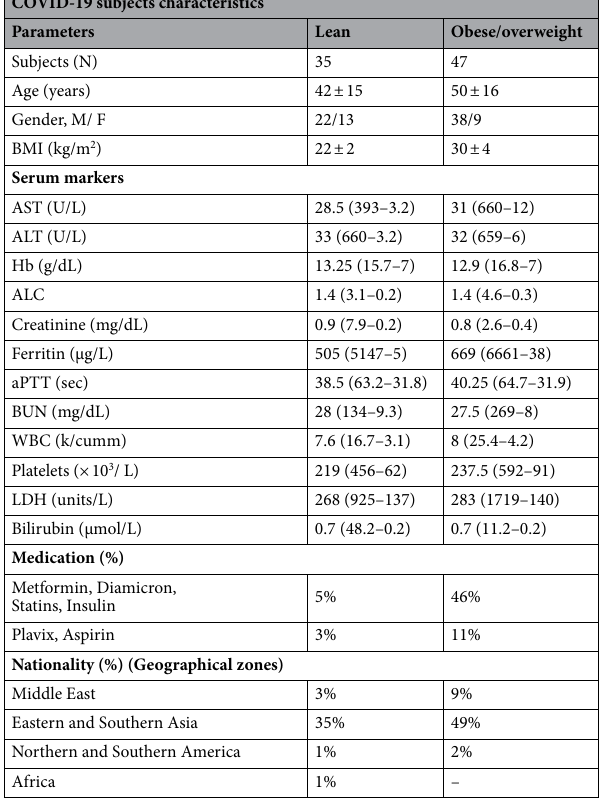
Table 3. COVID-19 patients’ characteristics. BMI body mass index; AST aspartate aminotransferase test, ALT alanine aminotransferase test; Hb haemoglobin; ALC haemoglobin A1c test; aPTT activated partial thromboplastin clotting time; BUN blood urea nitrogen; WBC white blood cell; LDH lactate dehydrogenase test. Values are shown as mean ± SD; median ( confidence intervals); %,